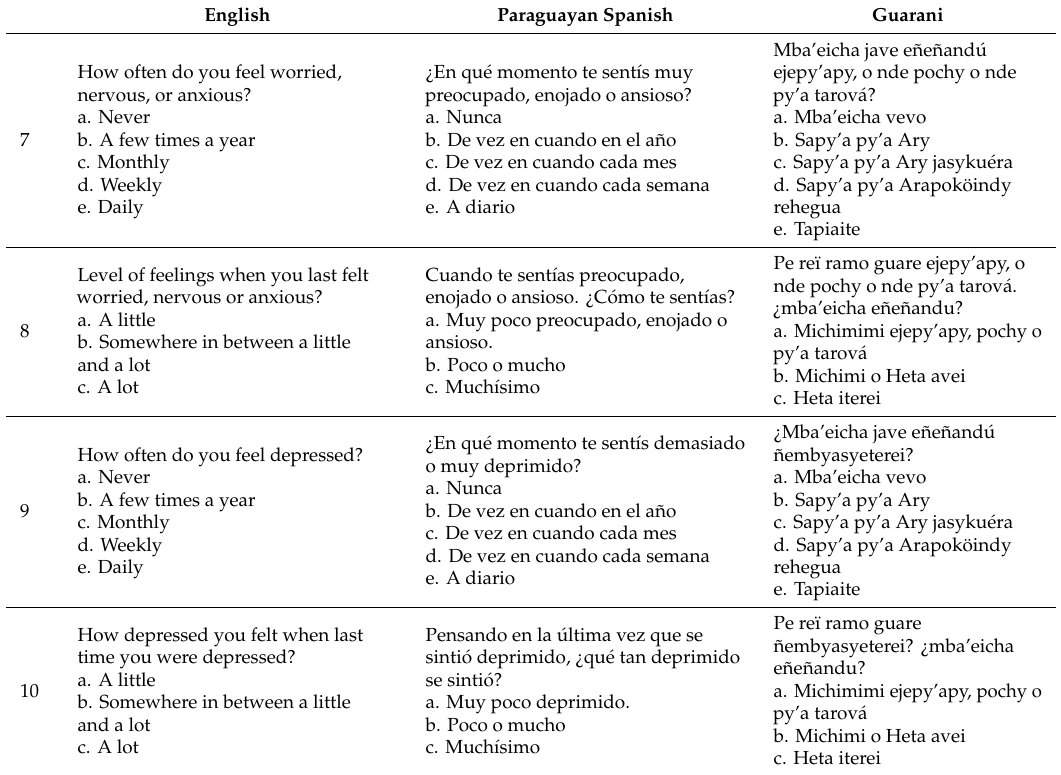
Table 2. Translated Washington Group extended set (WG-ES 3) questions and answers into Paraguayan Spanish and Guarani.